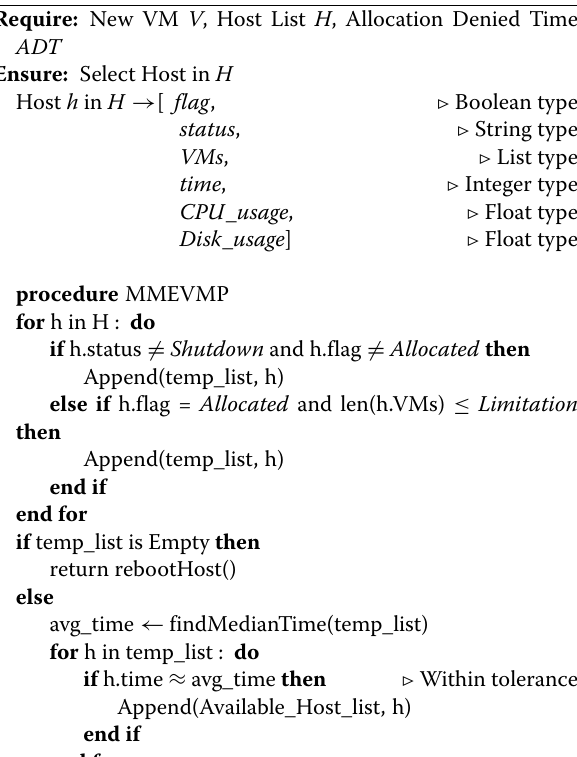
Algorithm 1 Min-Max Exclusive VM